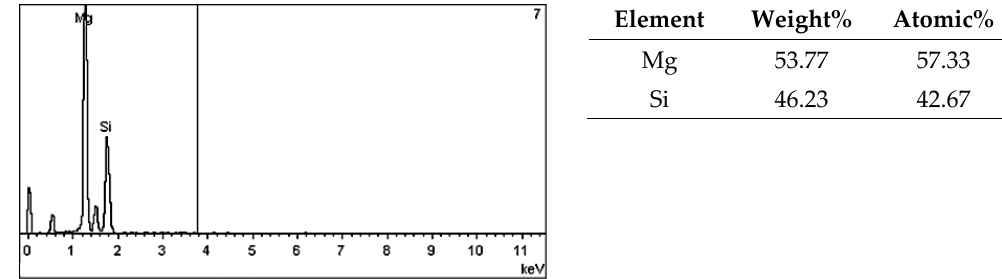
Figure 12. EDS diagram and chemical composition at point no. 7 of Figure 5.